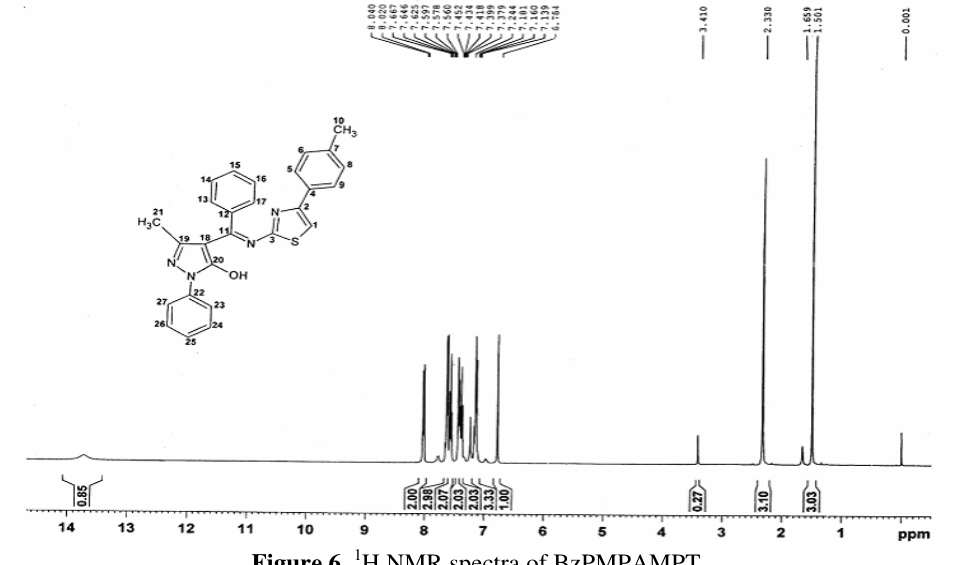
Figure 6. 1 H NMR spectra of BzPMPAMPT